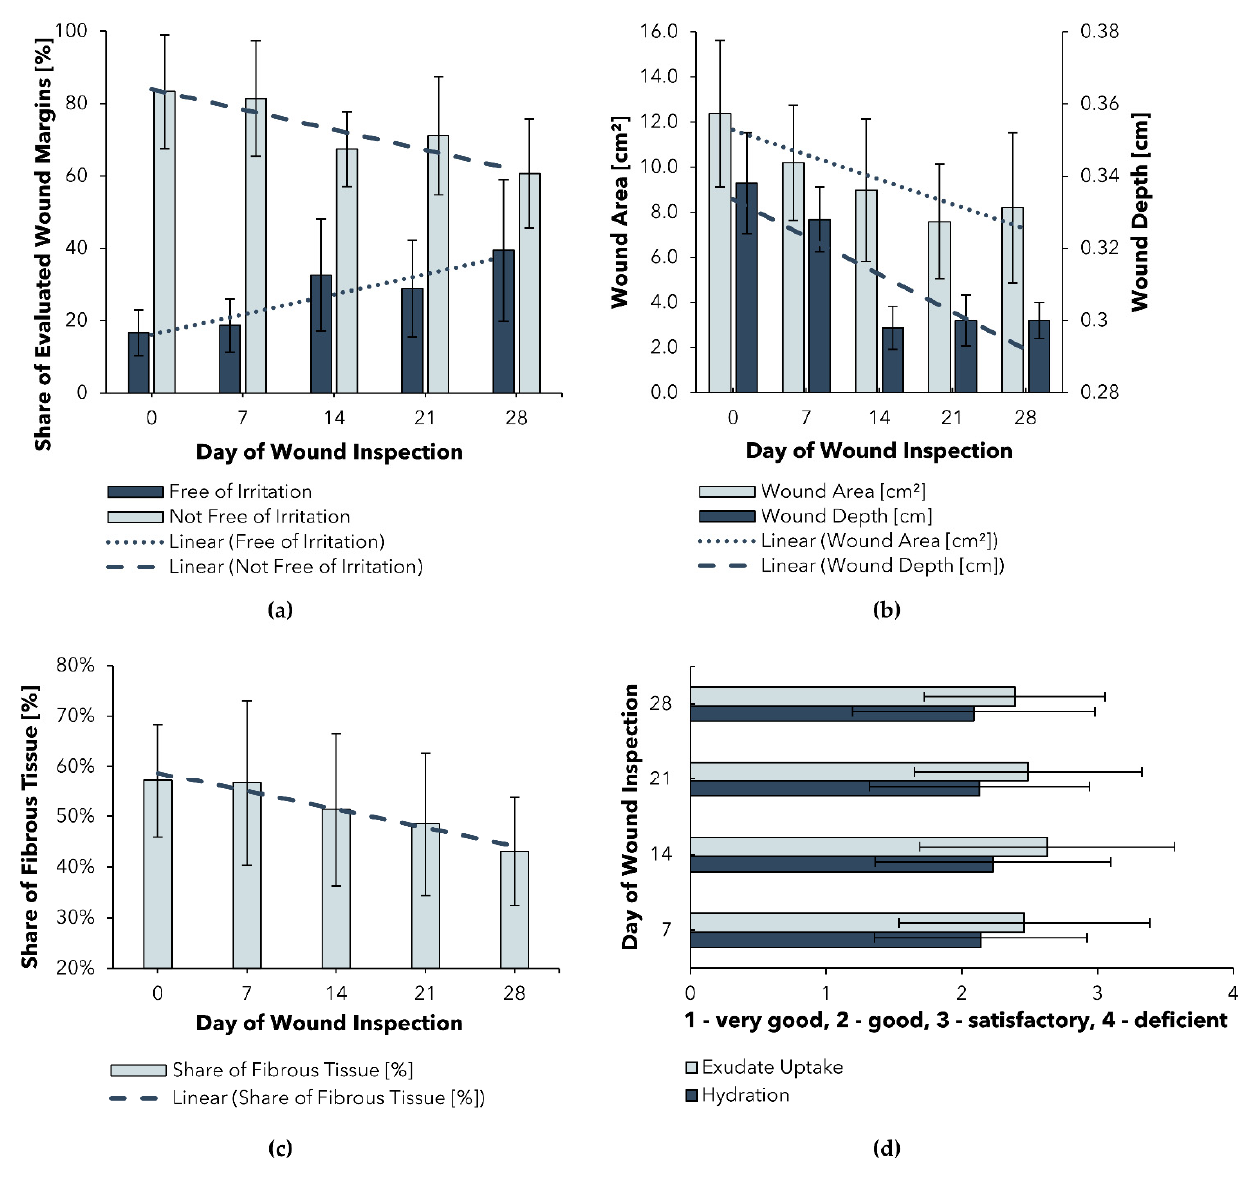
Figure 1. Selected results of a Post-Market Clinical Follow-up (PMCF) study of BC_A: ( a ) Progression of wound area and depth; ( b ) Progression of wound margin irritation; ( c ) Progression of fibrous tissue share; ( d ) Assessment of exudate management; time points of wound inspections ±3 days.